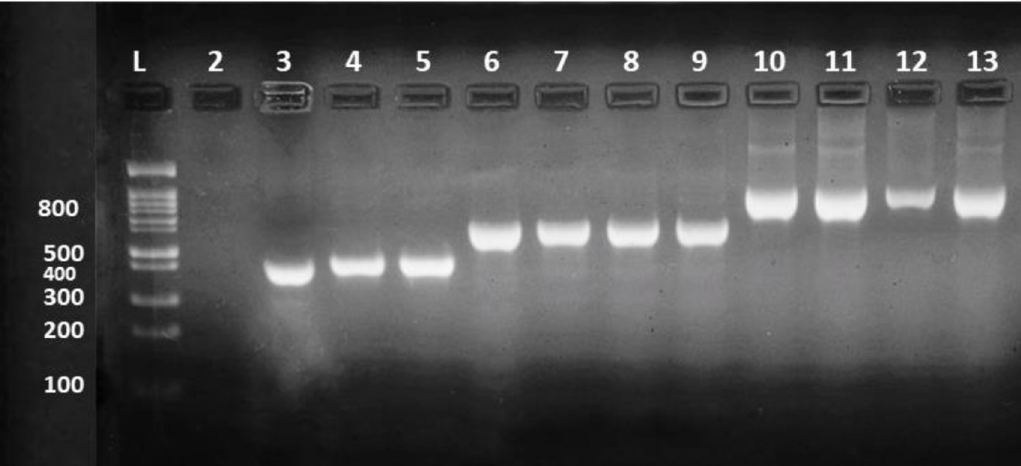
Fig 3. Detection of the carbapenemase genes OXA, NDM, and KPC in carbapenemase-producing Gram-negative bacilli isolates, using singleplex PCR. Lanes 3–5 represent the positive OXA-48 gene, Lanes 6–9 represent the positive NDM gene, and Lanes 10–13 represent the positive KPC gene. Lane 1 is a 1-kb DNA ladder. Lane 2 corresponds to the negative control. The molecular size of the tested bla OXA-48 , bla NDM , and bla KPC carbapenemase genes are 438, 621 and 798 bp respectively.